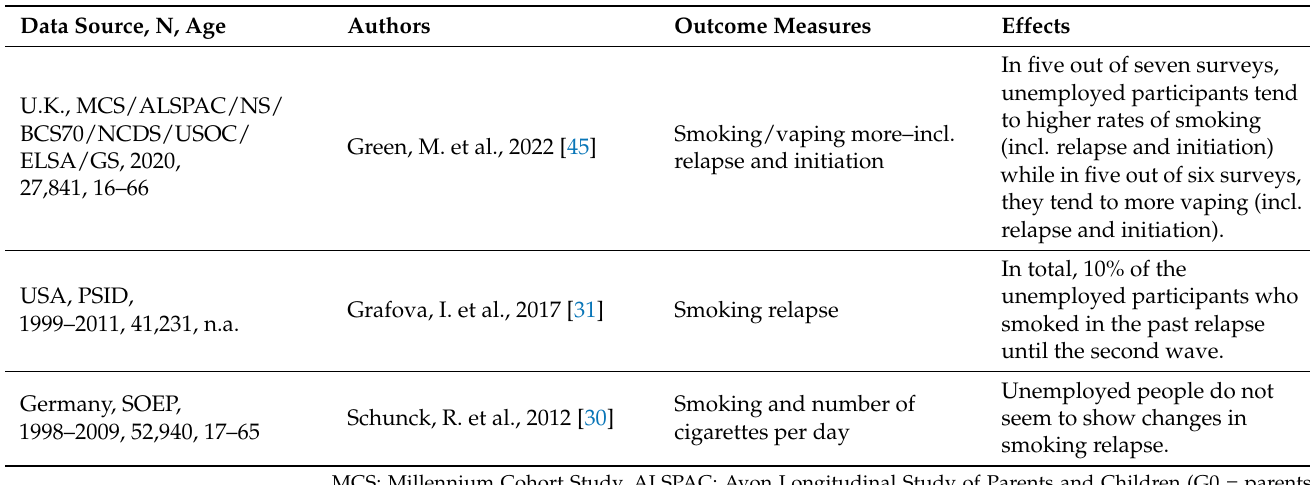
Table 4. Unemployment as a risk factor of relapses after treatment.